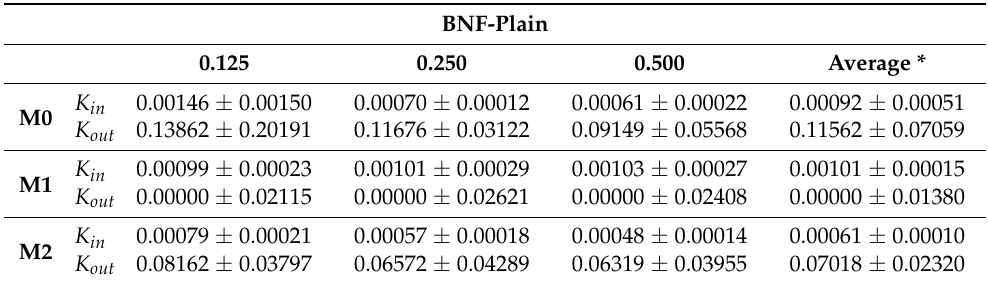
Table 2. Values of K in and K out obtained from the fitting shown in Figure 2 for BNF-plain using mean values.